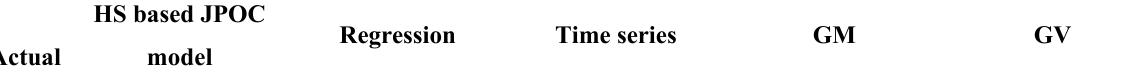
Table 5. Forecasting results of the HS-based JPOC model and other four single models for Russian Federation